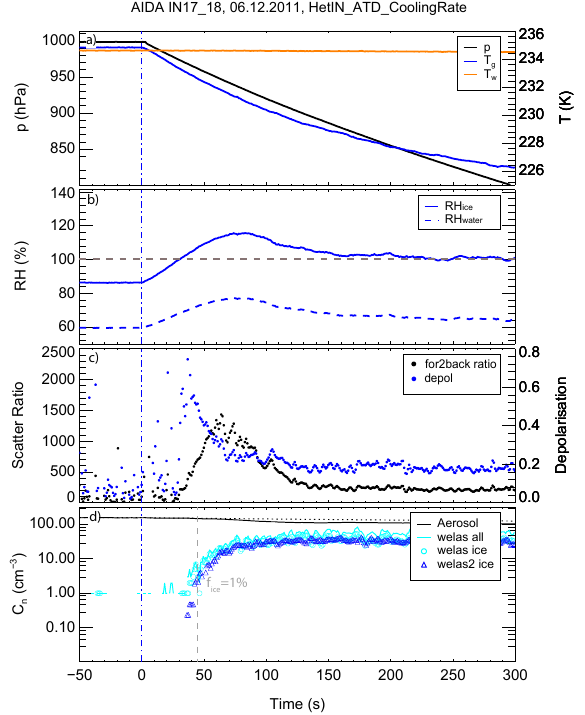
Figure 3. Time series for an AIDA expansion experiment in- vestigating deposition nucleation initiated by Arizona Test Dust. (a) Variation of thermodynamical variables during expansion: de- crease in gas temperature T g and pressure p ; temperature at the walls of the vessel ( T w ) stays approximately constant. (b) Rela- tive humidity over water and over ice as derived from TDL data. (c) Forward-to-backward scattering ratio and depolarization of the backward-scattered light as measured by SIMONE. (d) Aerosol number concentration (CPC3010) and ice crystal concentrations